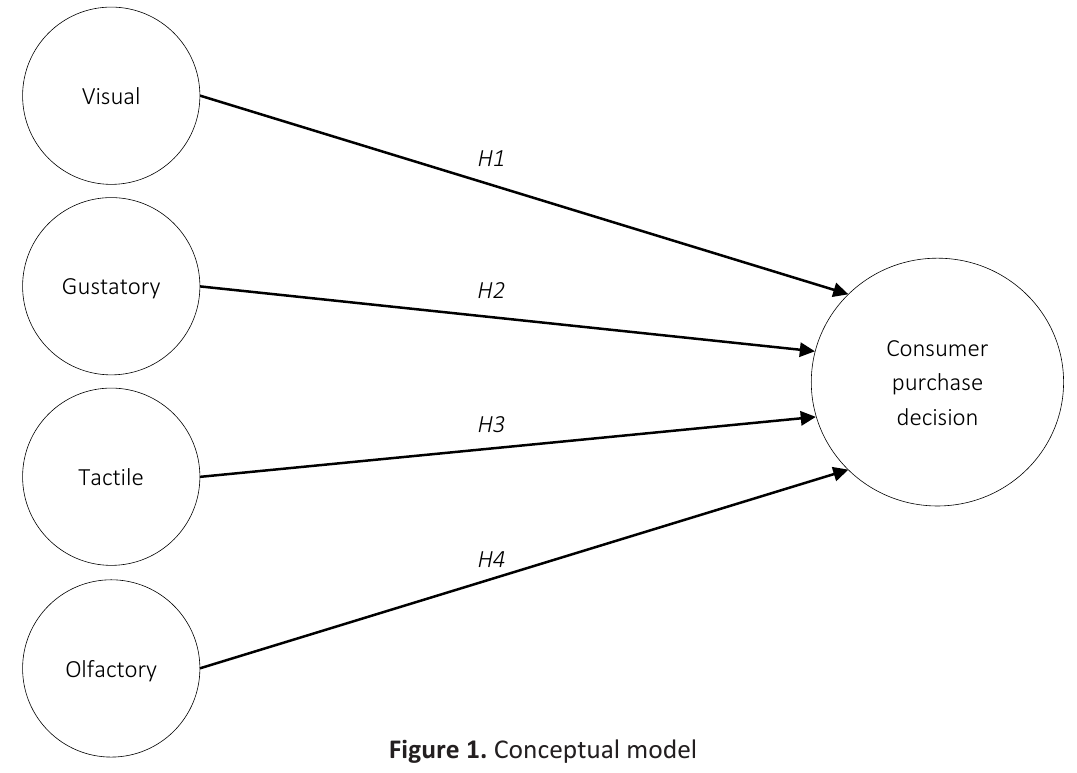
Figure 1. Conceptual